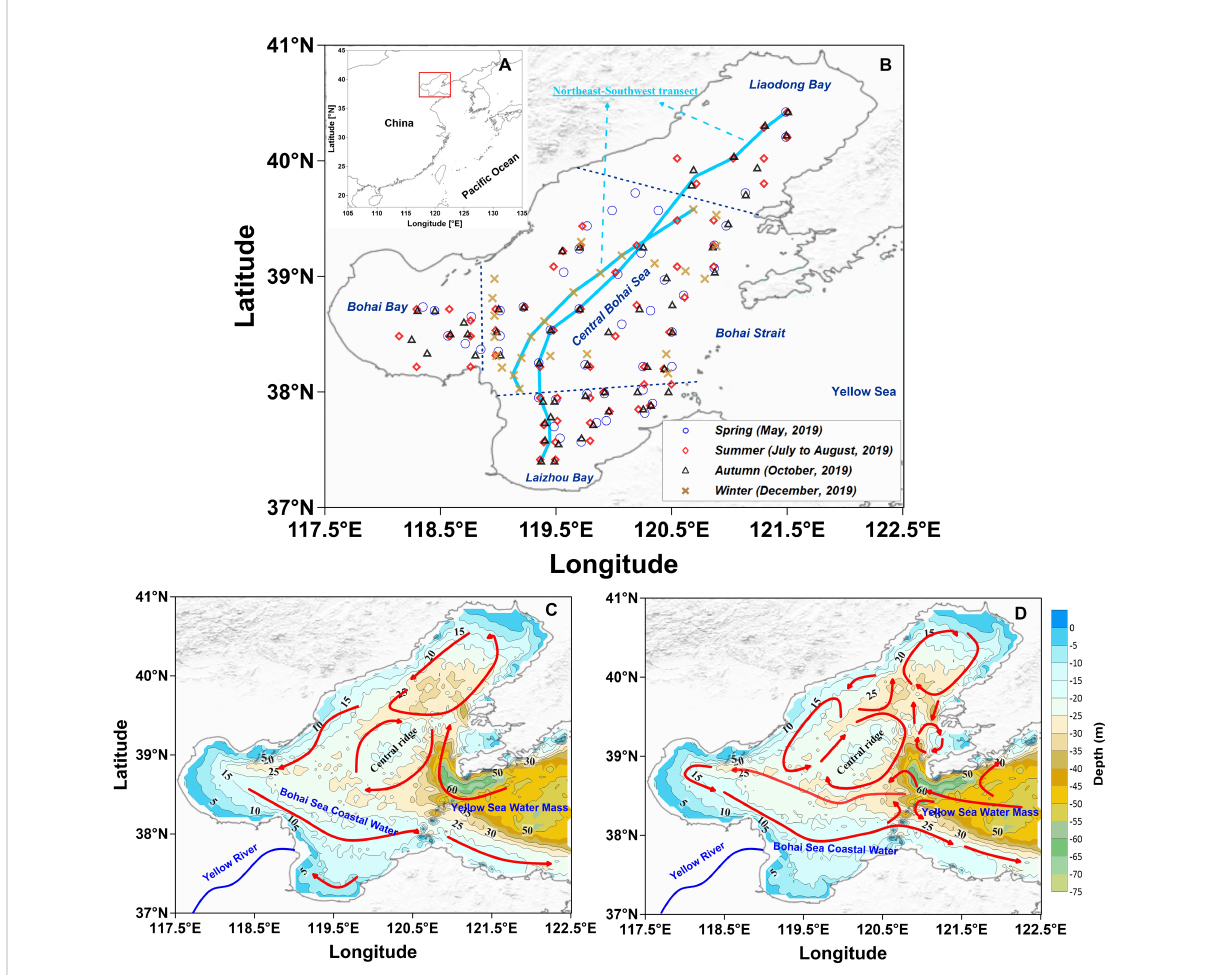
FIGURE 1 Maps showing the geography zoning of the Bohai Sea (A) , sampling stations (B) , summer circulation (C) and winter circulation (D) . The summer circulation and winter circulation are redrawn from Zhou et al. (2017) and Fang et al. (2000), respectively. The bold solid lines in sky blue (A) represents the Northeast-Southwest transect